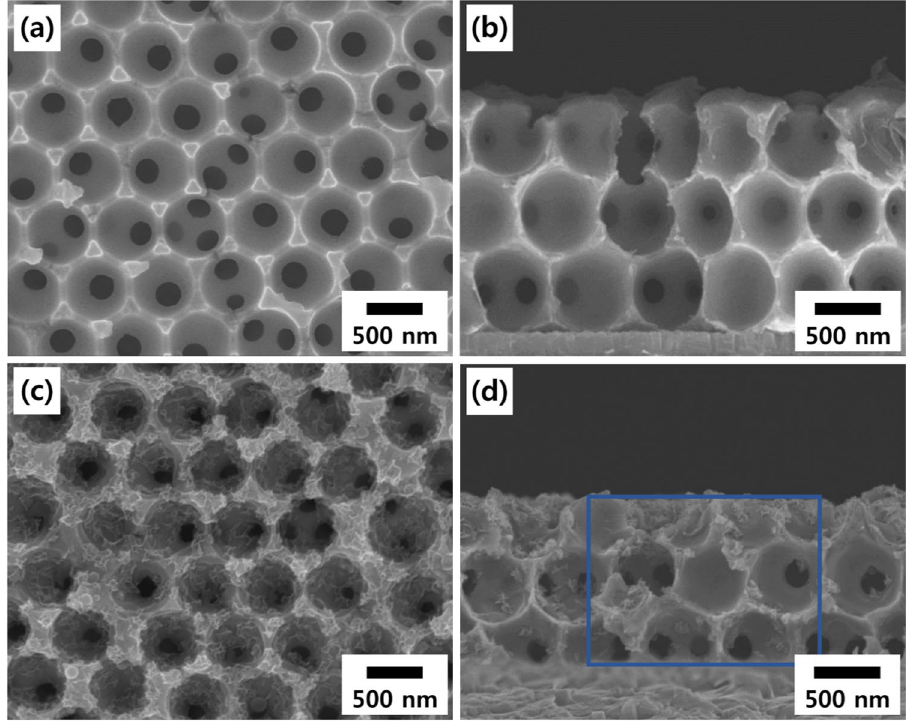
Figure 2. Morphology characterization of the current collector and electrode nanostructures. ( a ) Surface and ( b ) cross-sectional FE-SEM images of 3Lyr inverse-opal Ni nanostructures, and ( c ) surface and ( d ) cross- sectional FE-SEM images after 10 cycle electrodeposition of MnO 2 on the Ni nanostructures. Elemental mapping images of the marked area in ( d ) are represented in the Supplementary Information (Figure